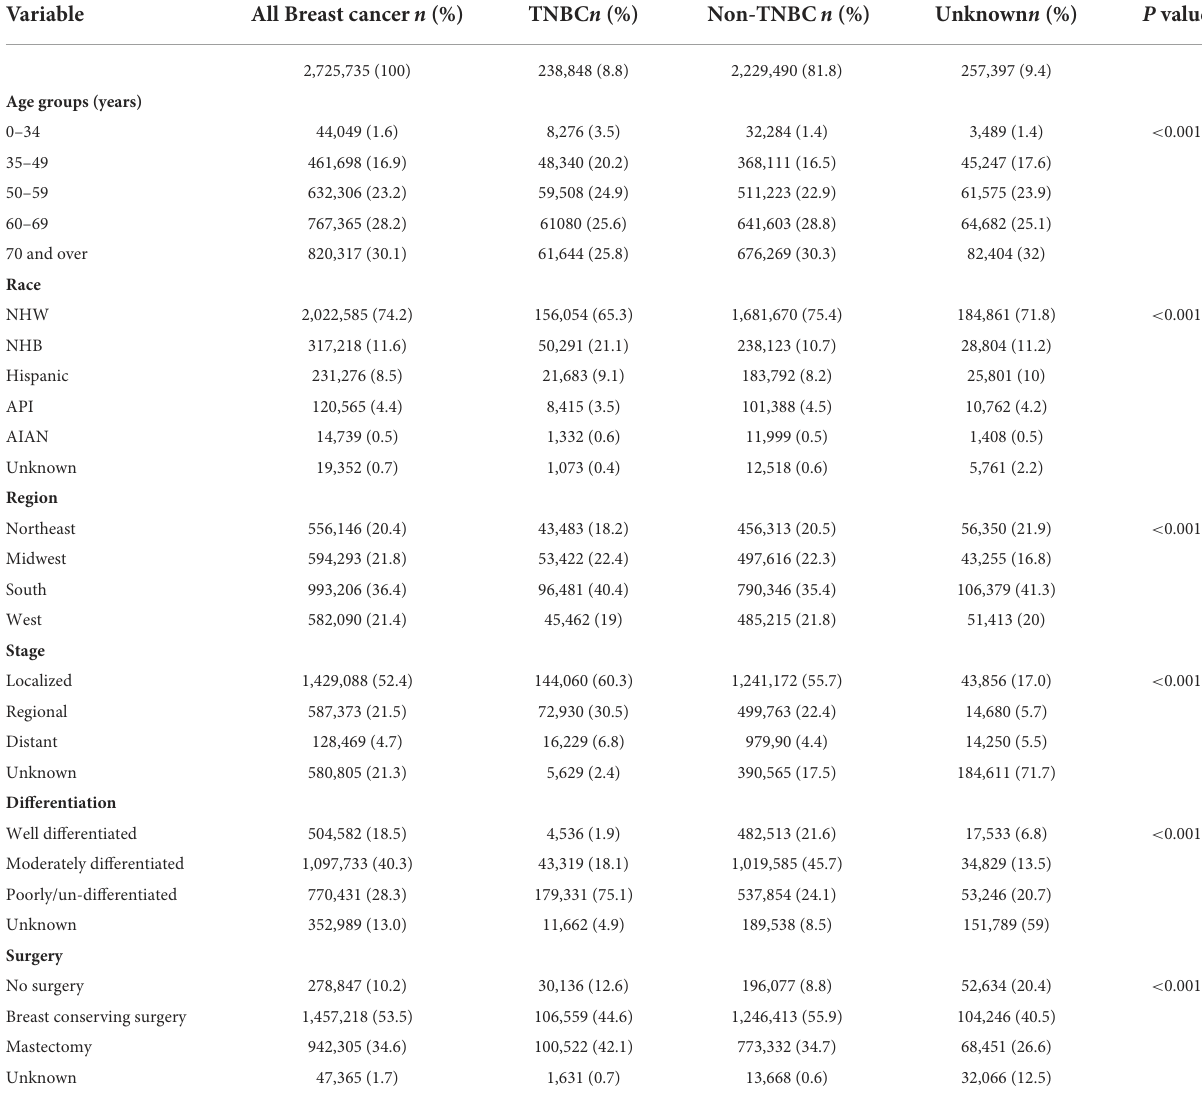
TABLE 1 Characteristics of newly diagnosed TNBC and Non-TNBC during